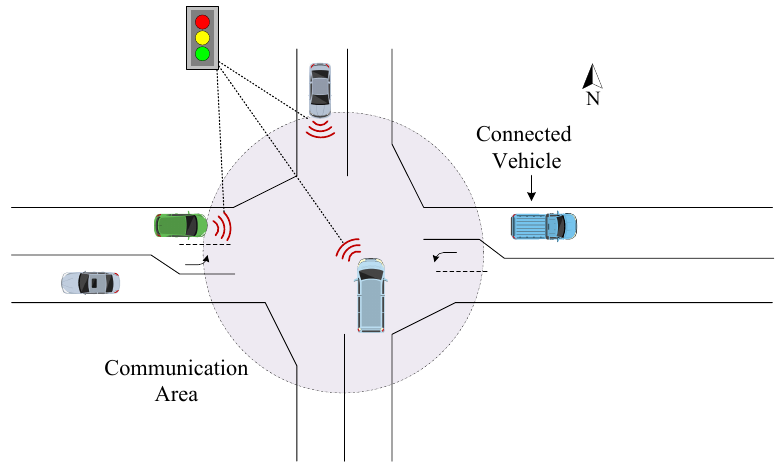
Figure 7. A signalized intersection. Table 1. Events in the transport safety model. Events